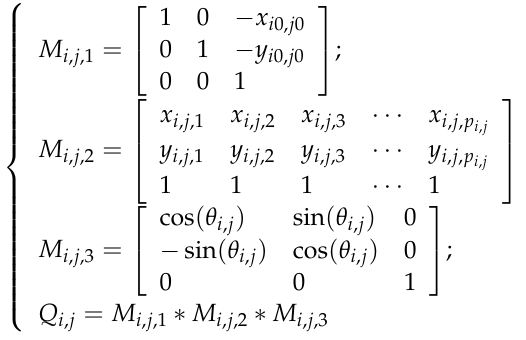
Table 1. Complex eye lenslet array process design parameters (unit: mm).